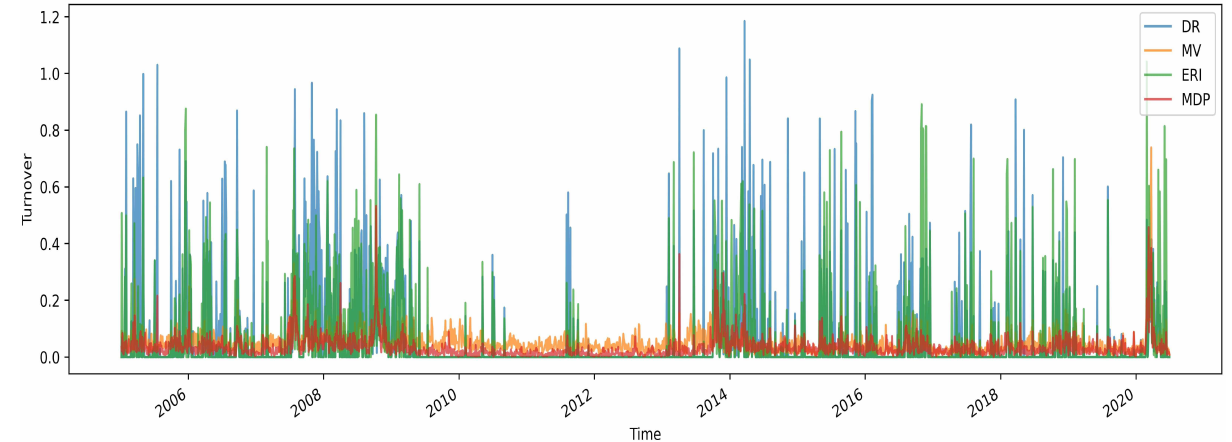
Figure 5. Turnover of DR, MV, MDP, and ERI for the 361-stock portfolio over the backtest